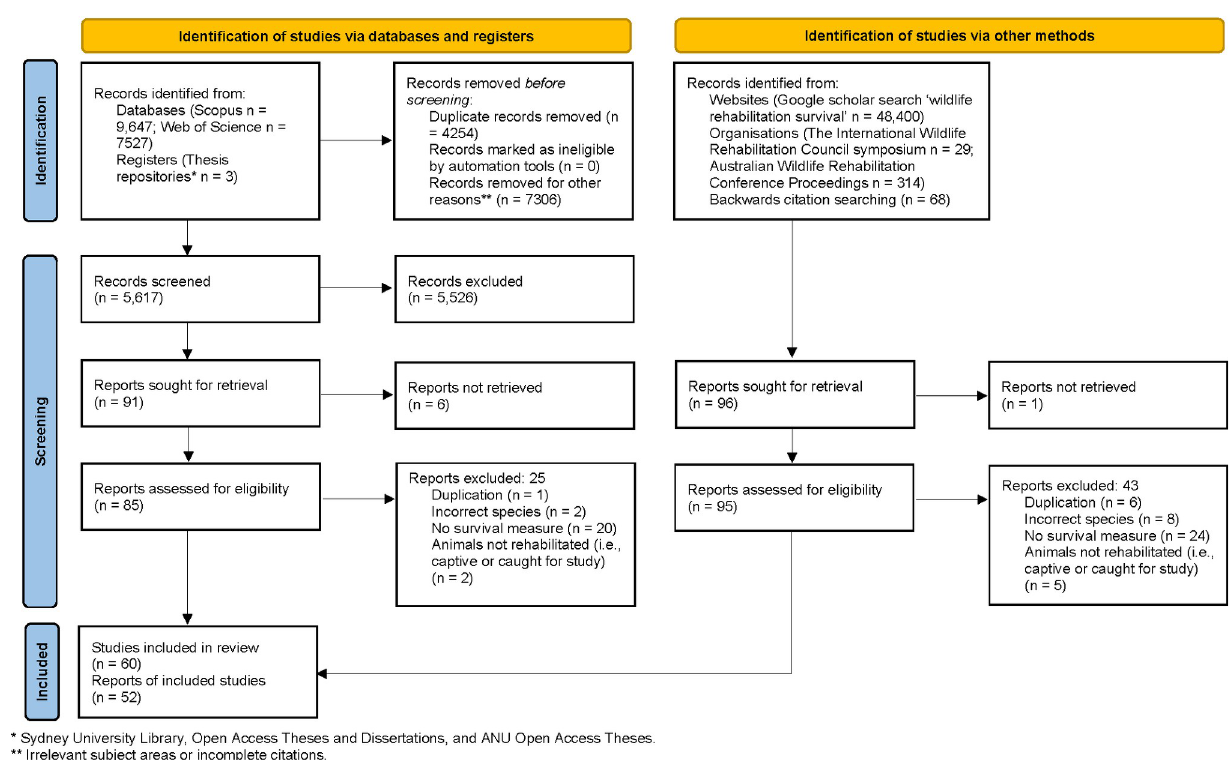
Fig 1. PRISMA flow diagram of systematic search strategy and results. Adapted from Page et al. [25].